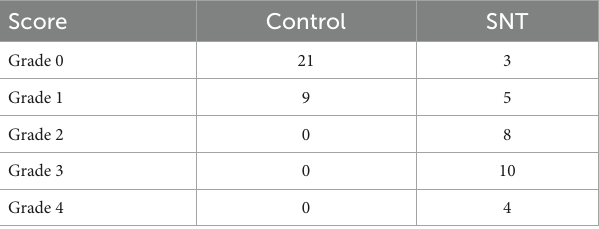
TABLE 3 Ultrastructural grading scores of all groups on the 3rd day after